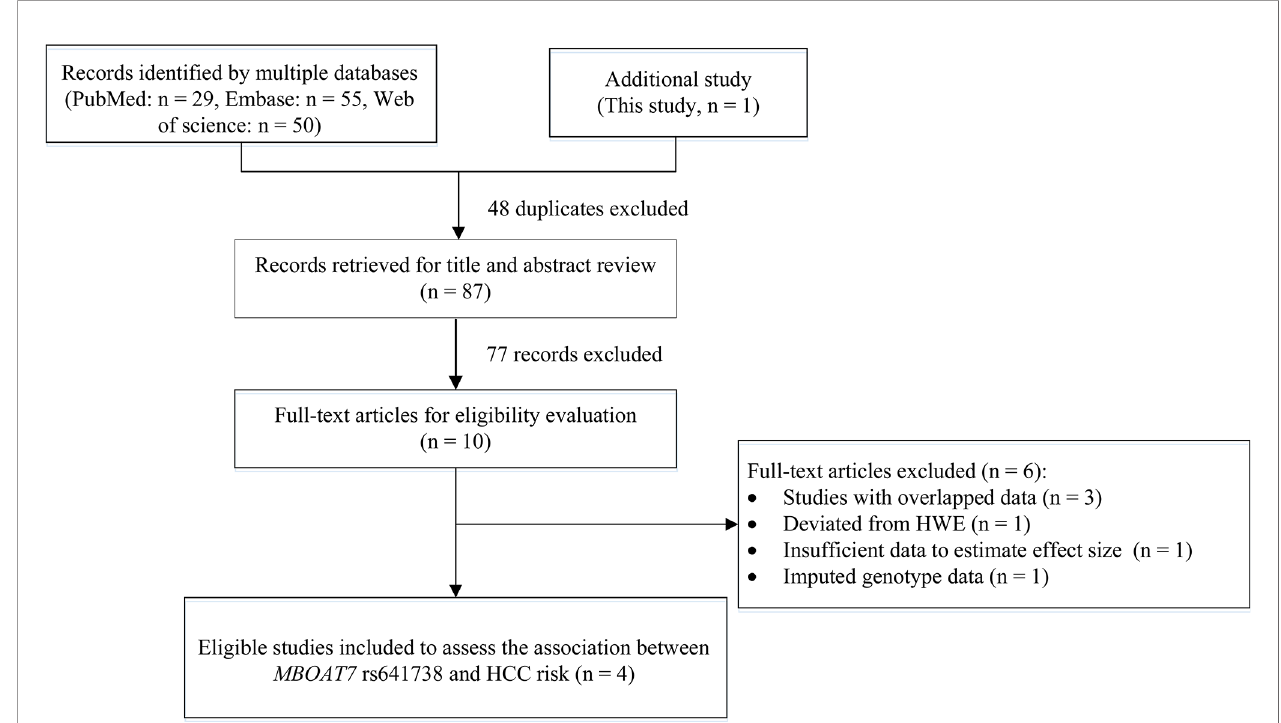
FIGURE 1 | Flowchart of literature search and study